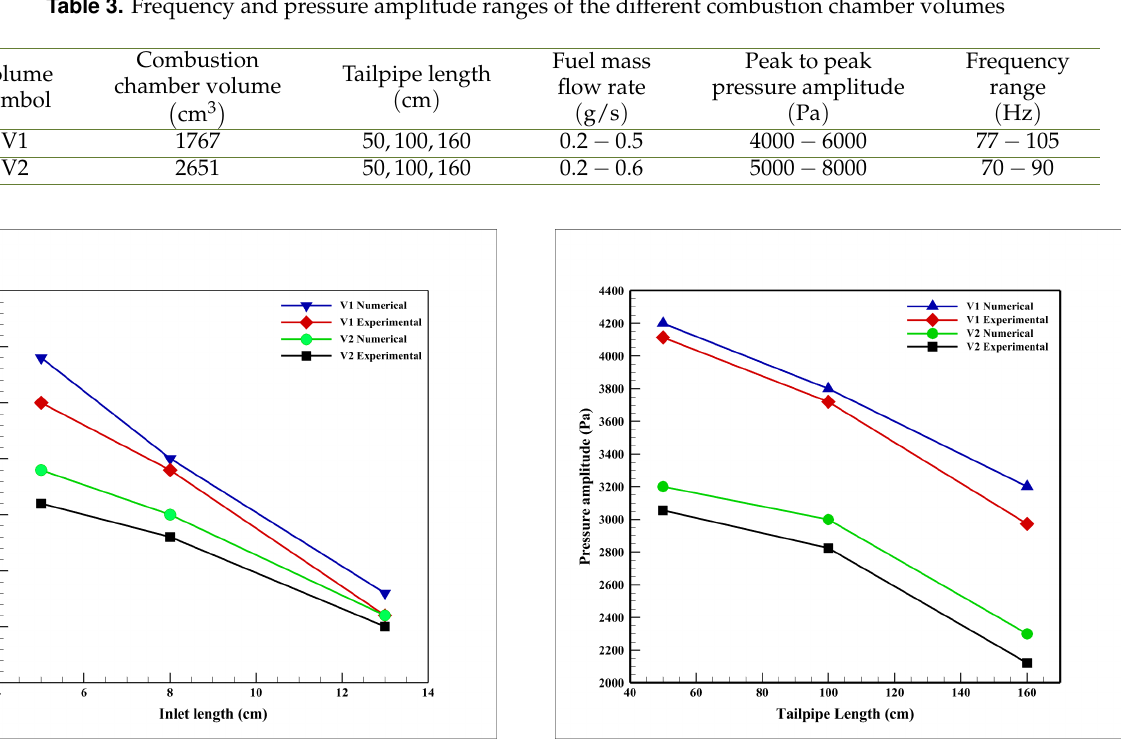
Table 3. Frequency and pressure amplitude ranges of the different combustion chamber volumes